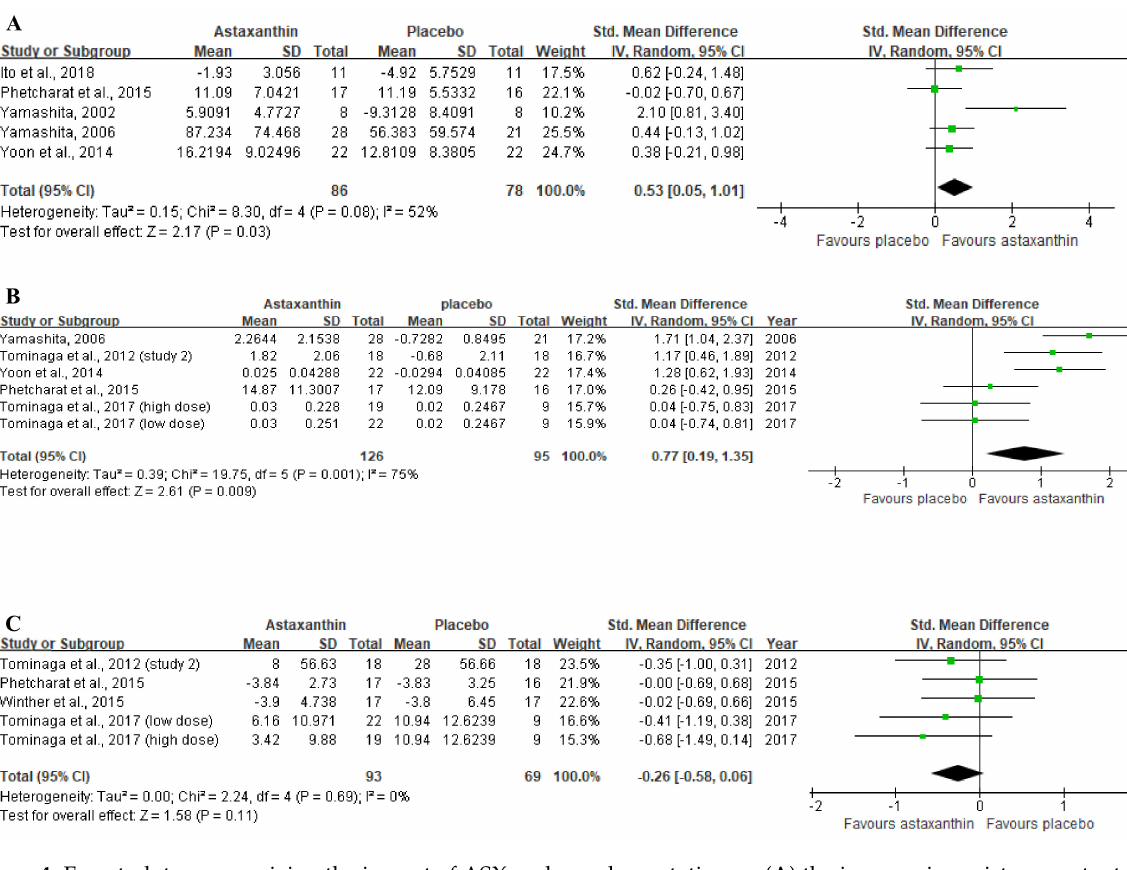
Figure 4. Forest plots summarizing the impact of ASX oral supplementation on ( A ) the increase in moisture content ( µ S), and ( B ) the increase in skin elasticity (%) using a random-effects model, as well as ( C ) the reduction in wrinkle depth ( µ m) using a fixed-effects model. Pooled summary data are presented as mean differences compared to control. The area of each green symbol is proportional to the weight of the study. Squares represent the standard mean differences, bars represent the 95% CI, and diamonds show the pooled